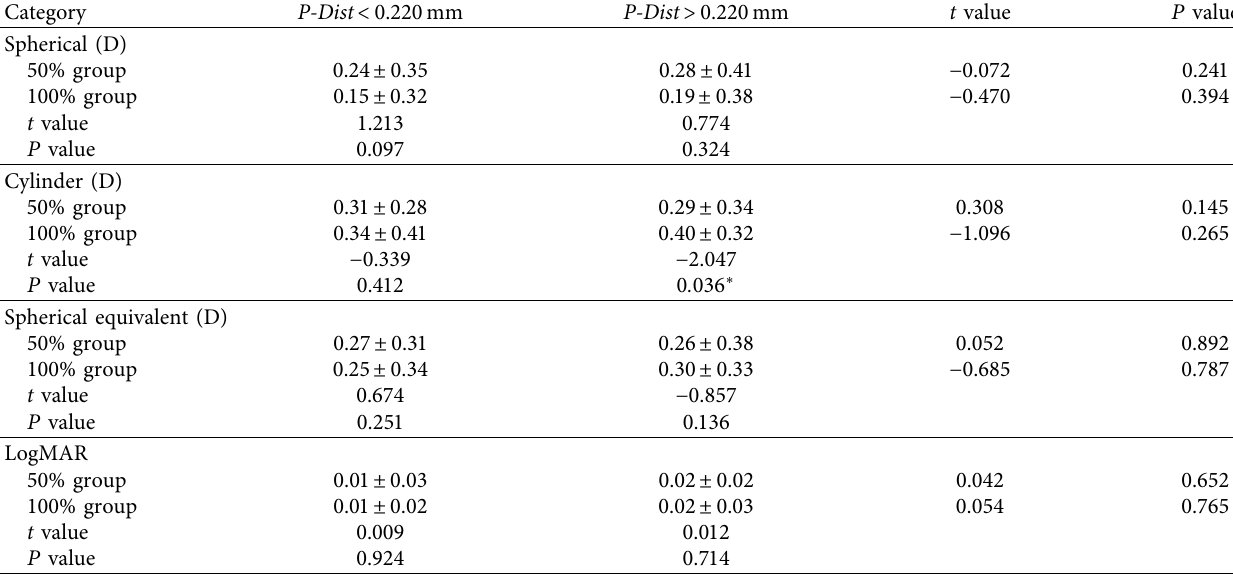
Table 2: Comparison of diopters between different P-Dist groups at 3 months.